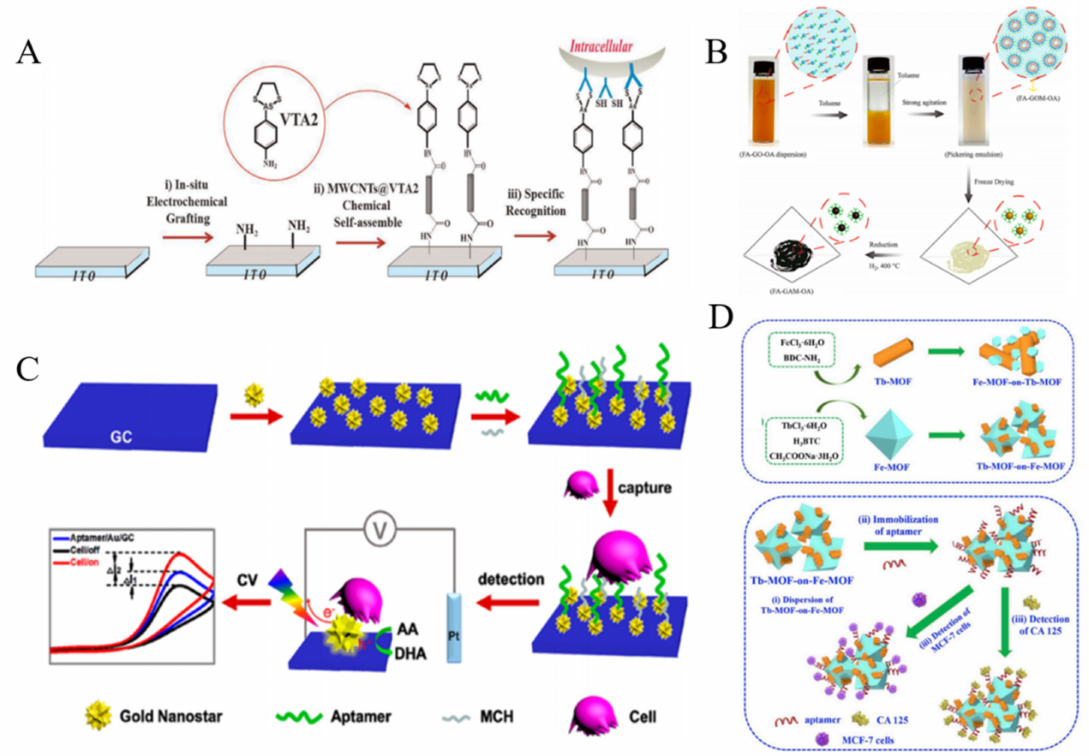
Figure 8. ( A ) Illustration of f assembling processes of 3D-MWCNTs@VTA2 cytosensor for detection of VDPs overex- pressed tumor cell [136]. Copyright 2015 Elsevier B.V. ( B ) Illustration of the procedure for synthesis of FA-GAM-OA